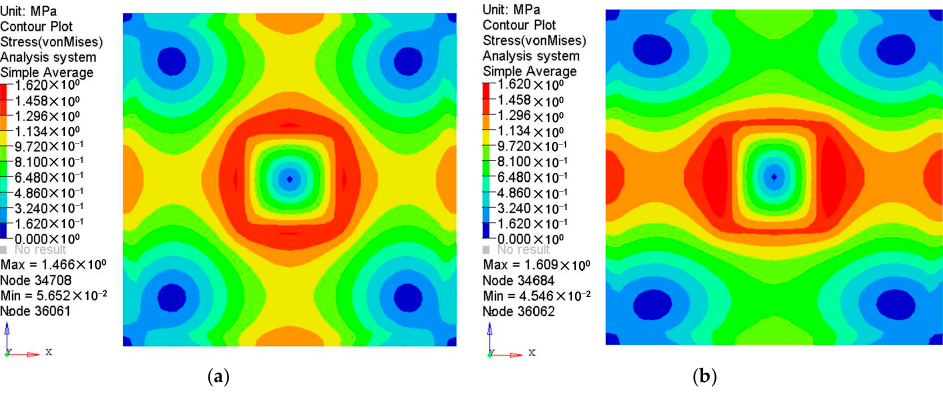
Figure 4. Stress distributions of ( a ) isotropic and ( b ) orthotropic plates under pressure of 0.1 MPa.